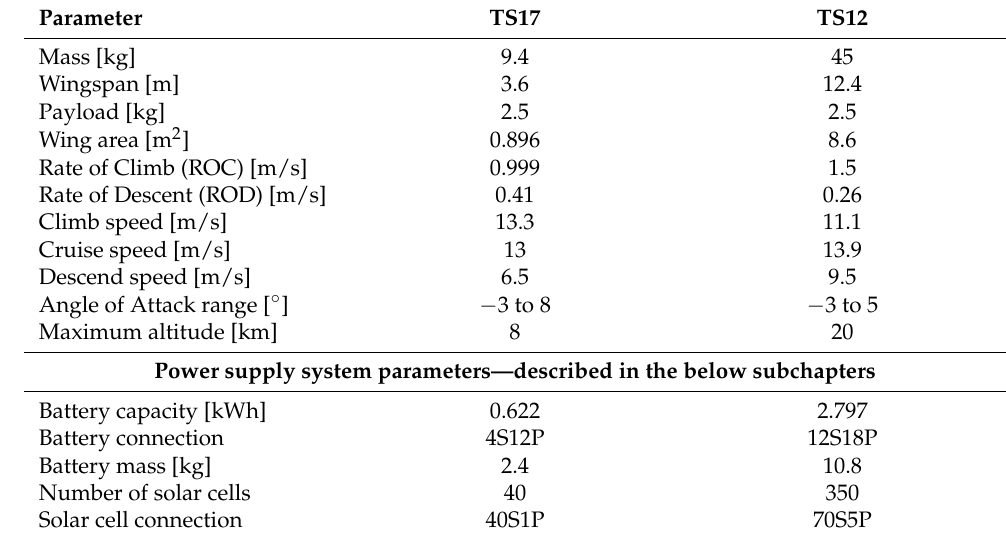
Figure 5. TwinStratos 17 prototype. Table 2. Parameters of TS17 and